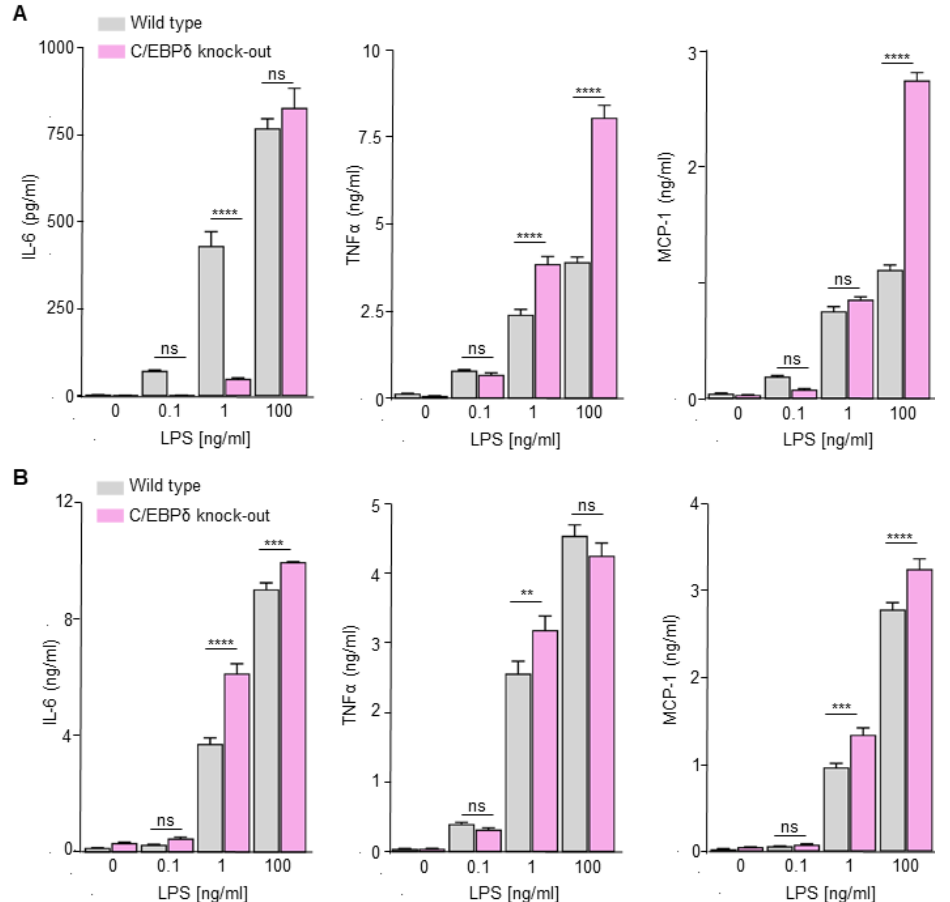
Figure 1. LPS-induced cytokine production in wild-type and C/EBP δ knock-out M-CSF differentiated BMDMs ( A ) and peritoneal macrophages ( B ). Macrophages from wild-type or C/EBP δ knock-out mice were stimulated with different LPS concentrations for 24 h after which TNF α , MCP-1 and IL-6 levels were analyzed. Shown is the mean ± SEM ( n = 6–8) of a representative experiment performed in duplo. **: p < 0.01; ***: p < 0.001; ****: p < 0.0001; ns: non-significant.